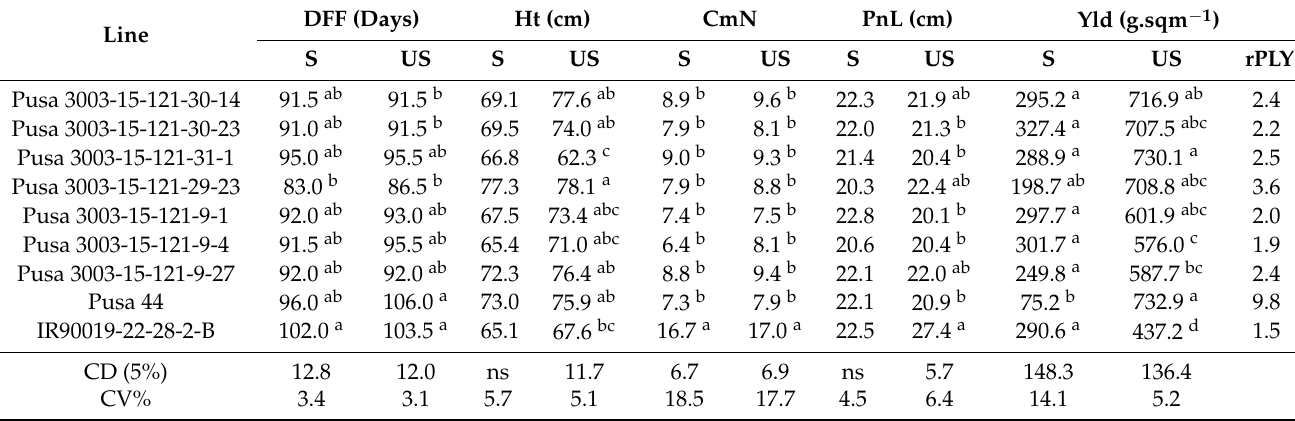
Table 4. Agronomic performance of Pusa 44 qDTY12.1 -NILs under stressed and unstressed conditions during Kharif 2018 in New